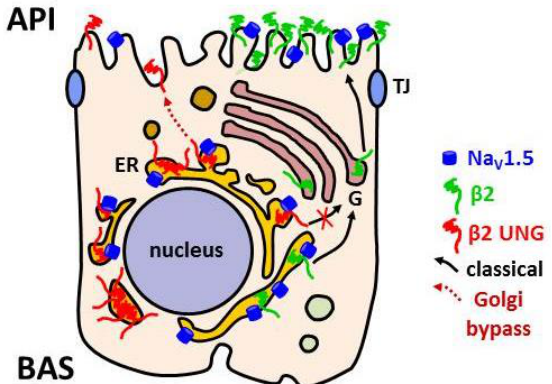
Figure 5. N-g lycosylation of β 2 is necessary for its targeting to the cell surface and to promote surface localization of Na V 1.5. Proper β 2 tra ffi cking is determinant for Na V 1.5 localization to the cell surface, and specifically, to the apical plasma membrane (API) in polarized MDCK cells. Unglycosylated (UNG; N42Q / N66Q / N74Q) β 2 is retained in the endoplasmic reticulum (ER), often seen together with Na V 1.5. By bypassing the Golgi apparatus (G), a fraction of the mutant can reach the cell surface (dotted arrow), but at a rate of only approximately one-third of that of the wild type. In addition, it is defective in promoting surface localization of Na V 1.5. BAS, basolateral surface; TJ, tight junctions.